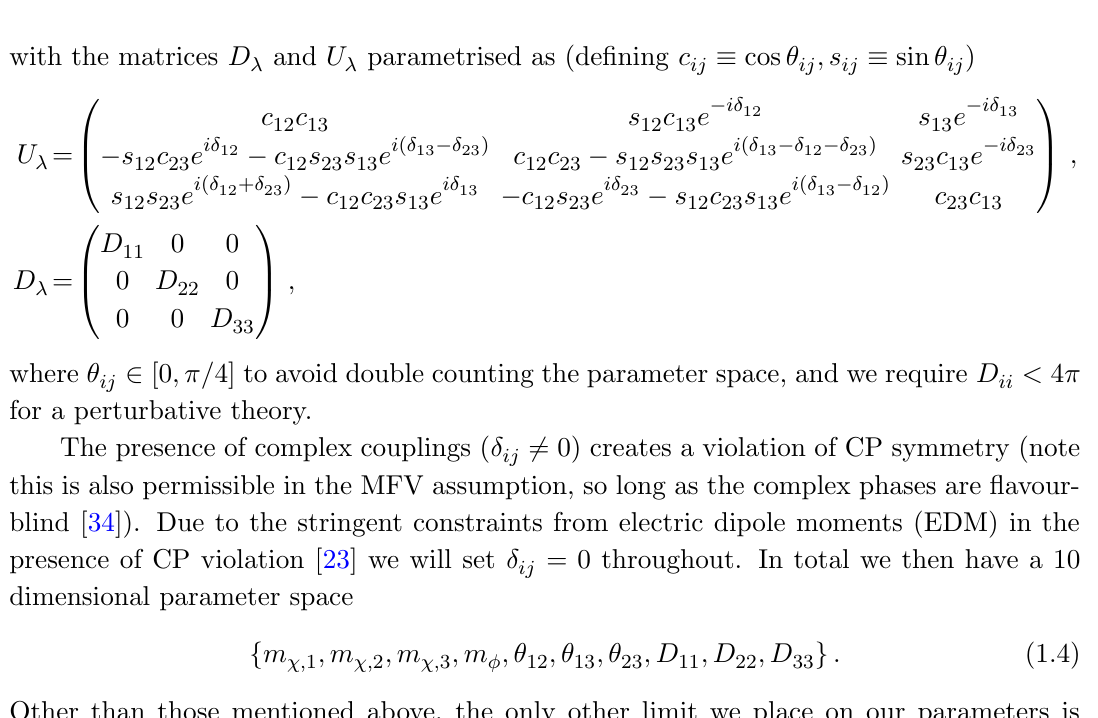
Table 1 . The representation for the relevant symmetries of the particles introduced in the DMFV model, along with the coupling matrix (cid:21) and the SM right-handed